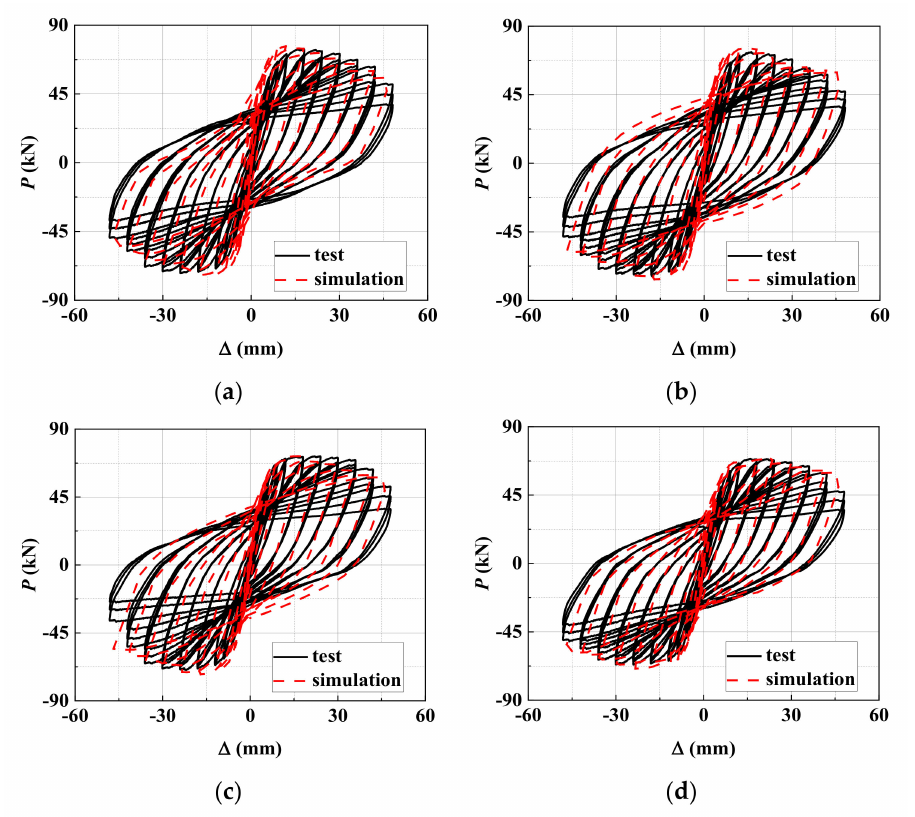
Figure 29. Comparison between numerical simulation and test results. ( a ) JP-F0. ( b ) JP-F1. ( c ) JP-F3. ( d ) JP-F5.